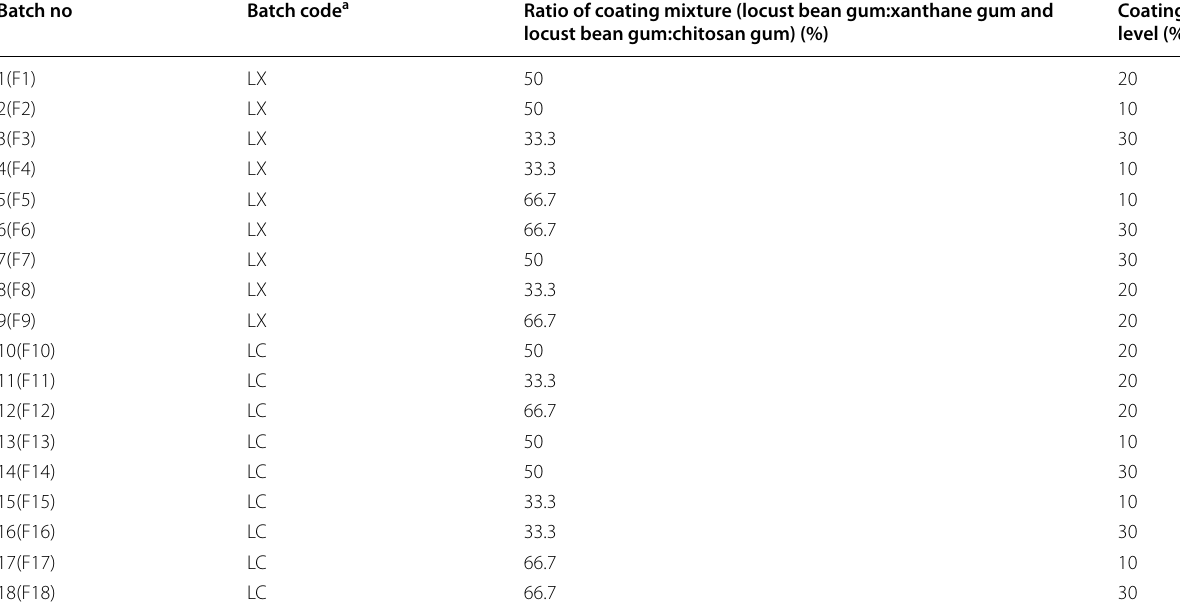
Table 1 Formulation of satranidazole multiunit